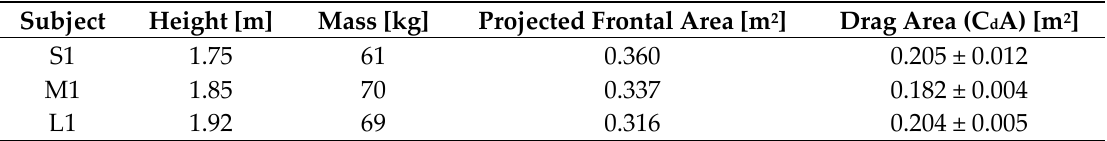
Table 1. Subjects’ anthropometric characteristics and individual drag area (m 2